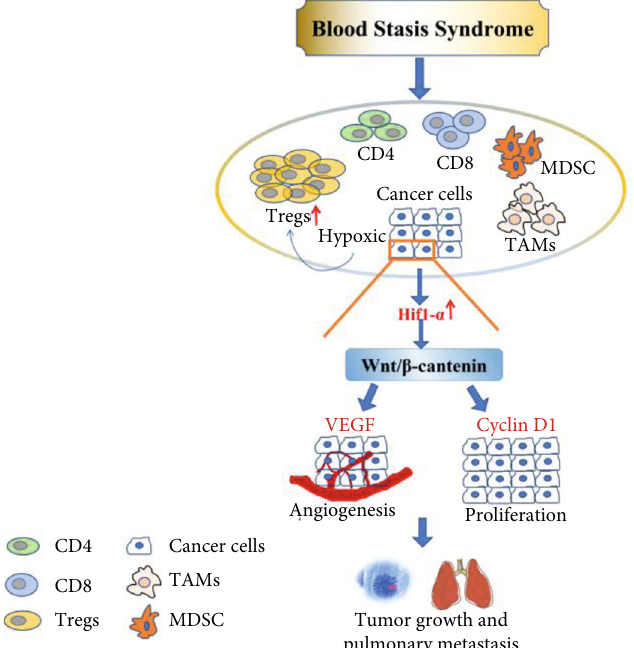
Figure 6: Schematic showing BBS mechanisms involved in regulating hypoxia and immunosuppressive microenvironment in breast cancer. By aggravating hypoxia tumor microenvironment, BSSs promote HIF1- α expression, thus upregulating VEGF and Cyclin D1 through the Wnt/ β -catenin signaling pathway, which promoted tumor angiogenesis; additionally, HIF1- α promotes the immunosuppressive microenvironment formation, thereby promoting the growth and metastasis of tumor